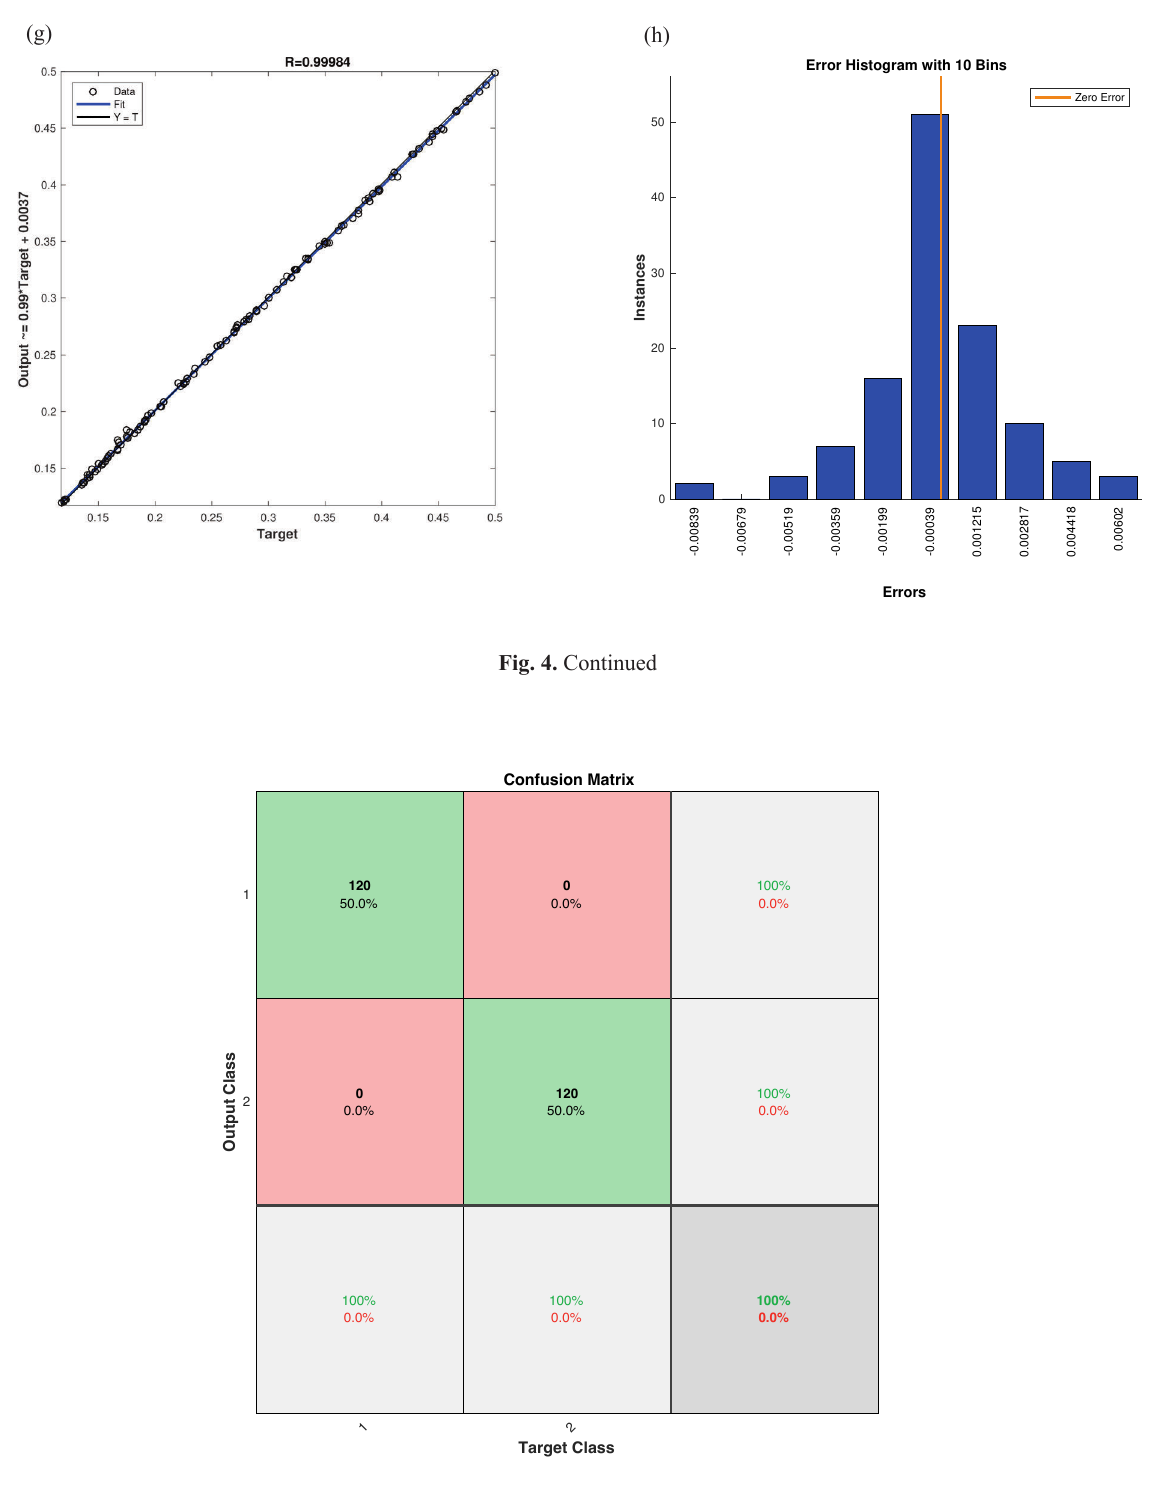
Fig. 5. Confusion matrix of the predicted and actual numbers of cracks in the